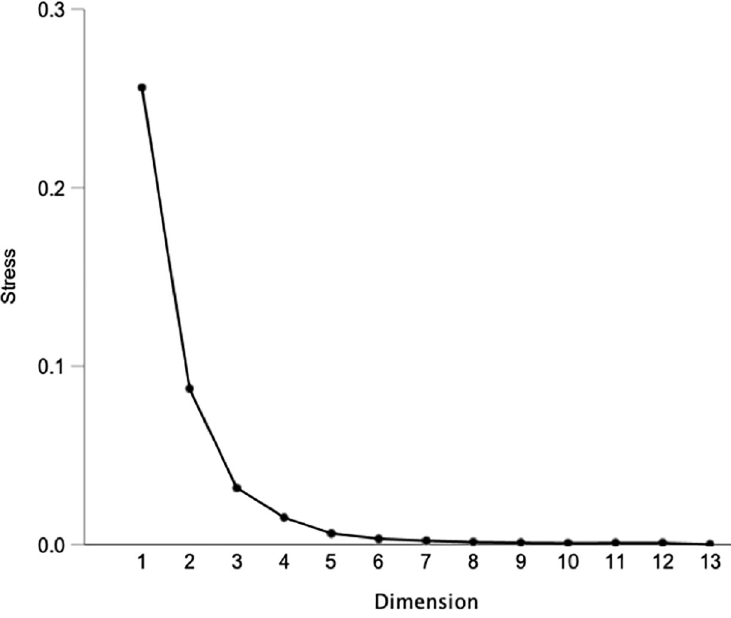
Fig 2. Scree plot for Multidimensional Scaling (MDS) of similarity matrix obtained from napping experiment.